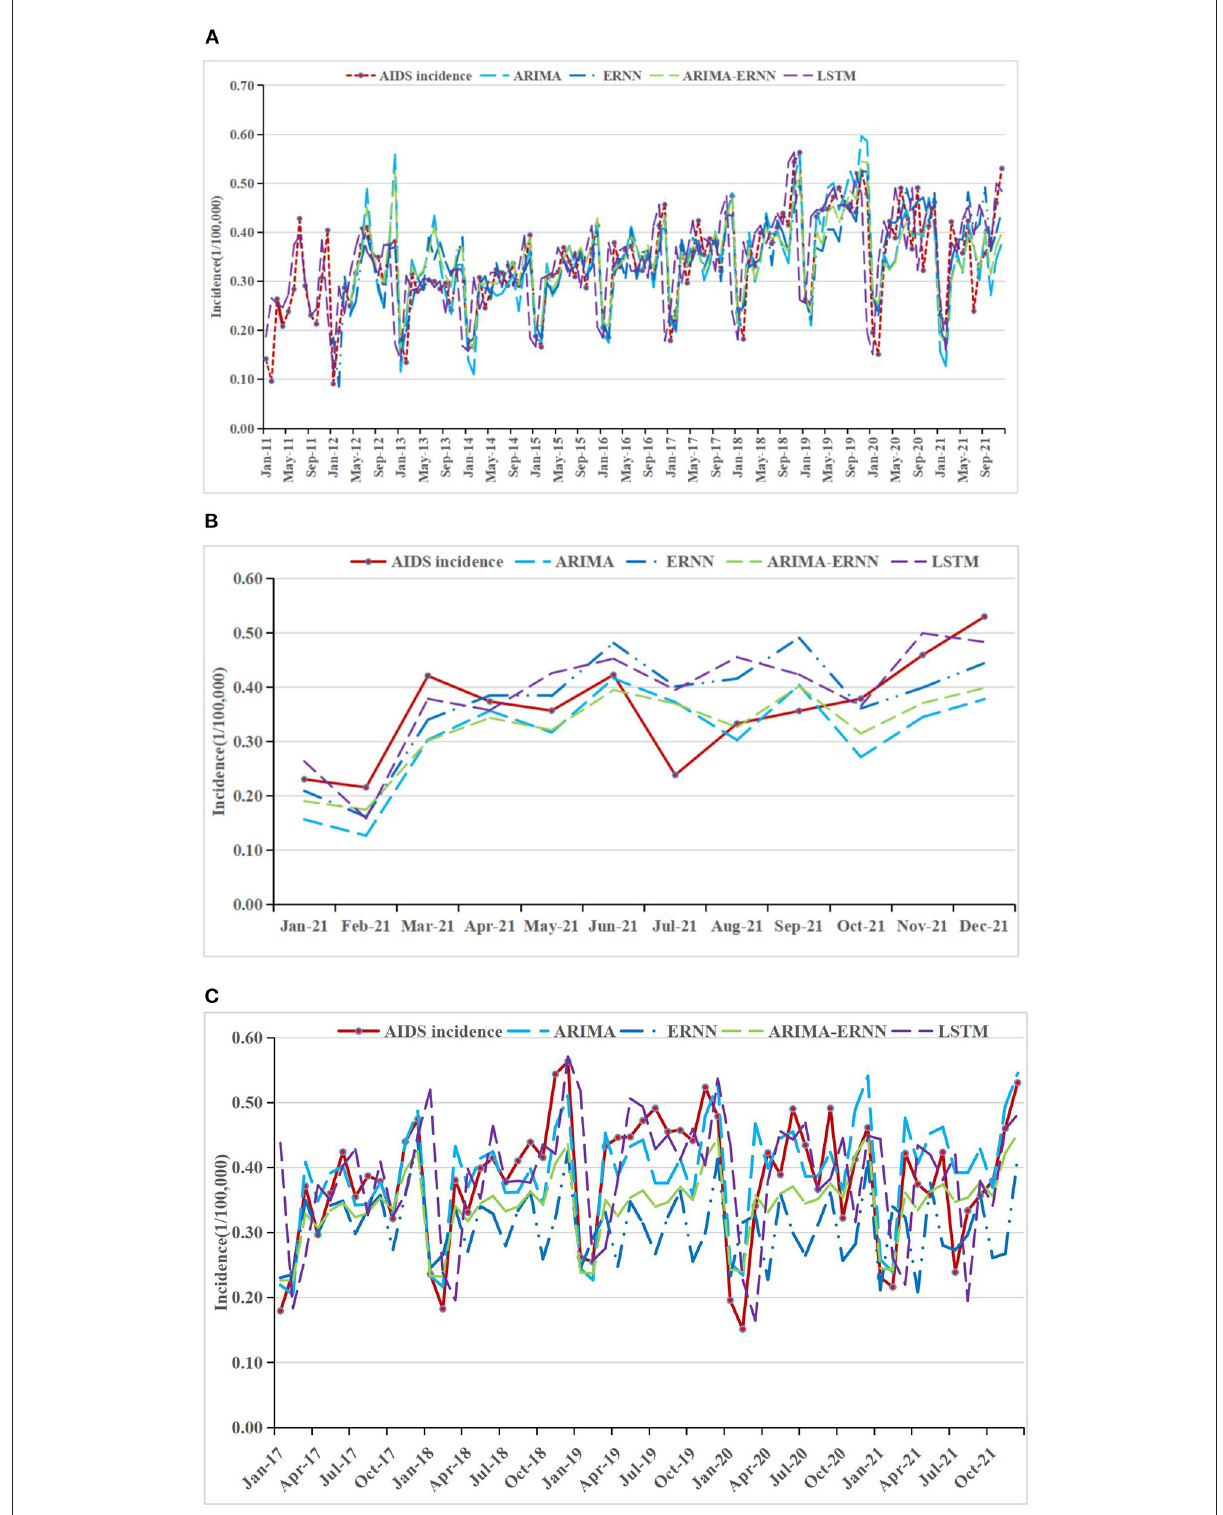
FIGURE2 AIDS incidence and fitting values predicted by the four methods (A) in 2011–2021, (B) in 2021, and (C) in